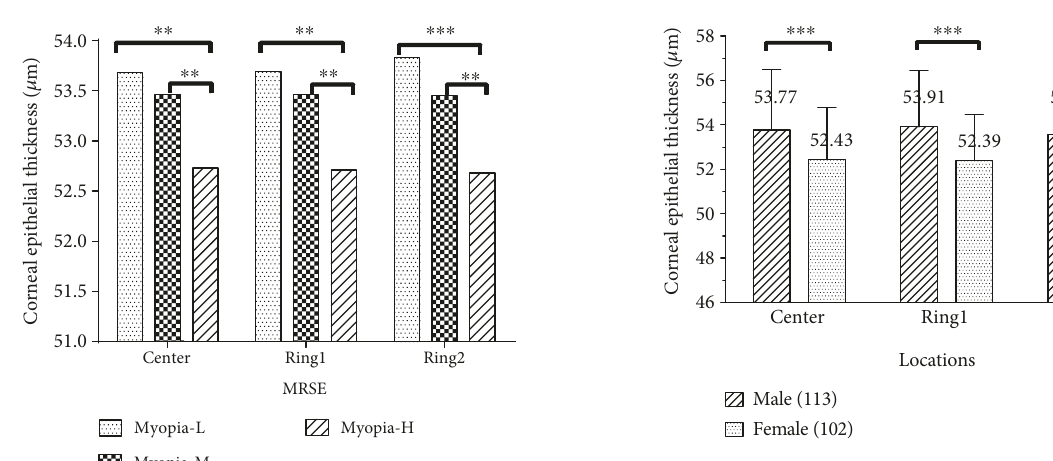
Figure 6: Di ff erence of corneal epithelial thickness between male and female in three locations. ∗∗∗ indicates P < 0 001